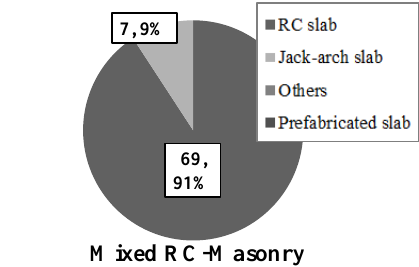
Figure 4. Occurrence of different horizontal structural systems within the dataset of 1067 buildings.